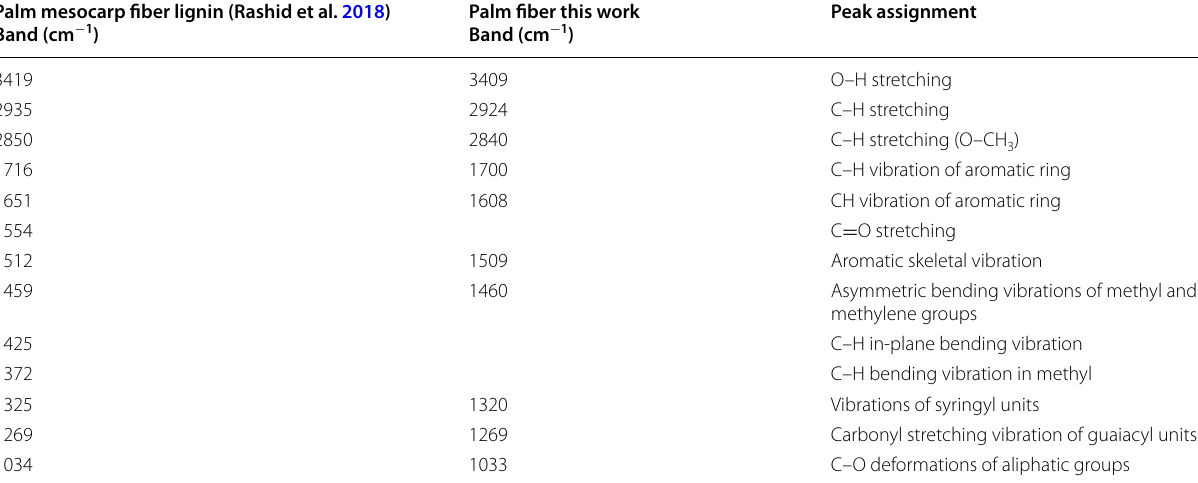
Table 6 FTIR band assignments for the lignin extracted from palm fibers Palm mesocarp fiber lignin (Rashid et al. 2018) Band (cm − 1 )